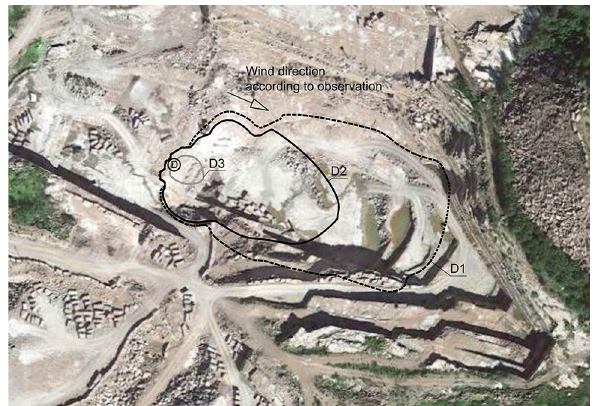
/m 3 from the Fig. 5 Modelled concentration contours of the model C5 and the 10 measured PM concentrations near two stages crushing. X is the 10 measurement location in the downwind (DW) direction. Aerial pho- tograph: Google Earth Pro